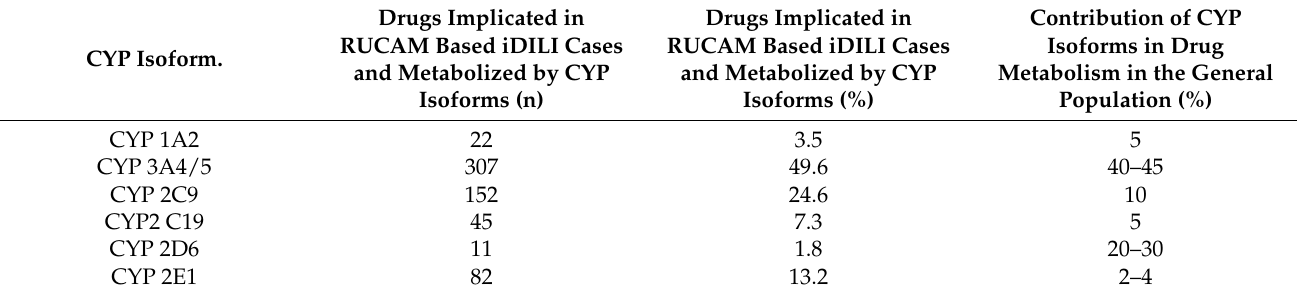
Table 3. Ranking of CYP isoforms involved in drug metabolism of patients with RUCAM based iDILI [3,5,21] as compared with the general population without iDILI [12]. Data were partially modified from previous publications [3,5,21]. Listed are drugs implicated in 619 RUCAM based iDILI cases and metabolized by CYP isoforms, data are given in number for drugs(n) and in percentages (%) as metabolized by CYP isoforms. These data were compared with the contribution of CYP isoforms in the general population without iDILI [12]. Abbreviations: CYP, Cytochrome P450; iDILI, idiosyncratic drug induced liver injury.